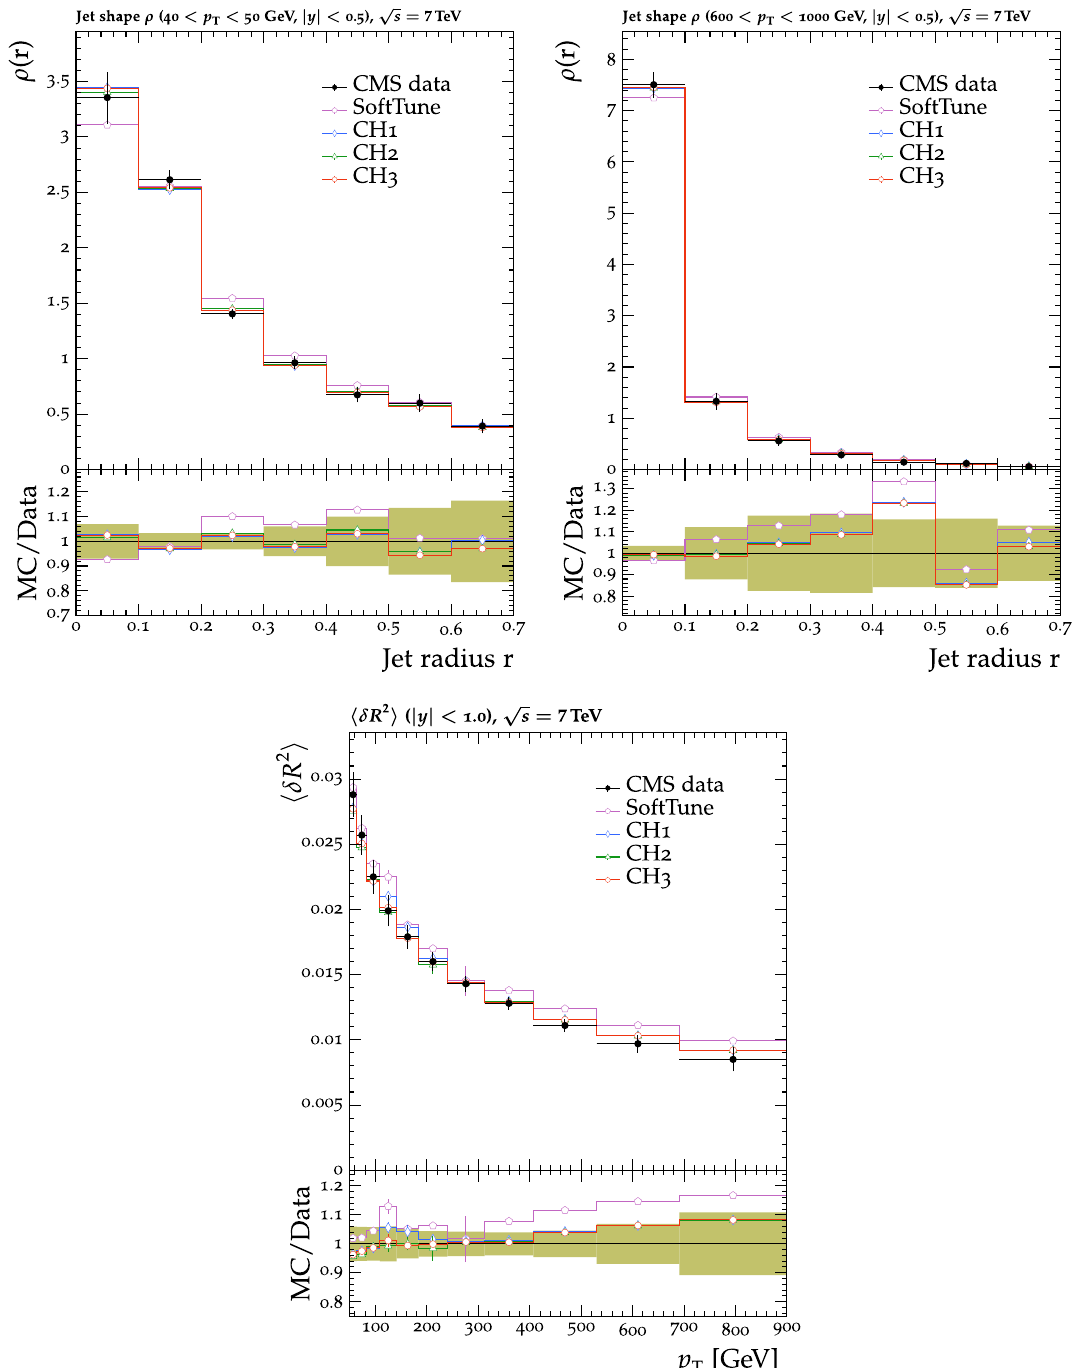
Fig. 15 The differential jet shape ρ( r ) (upper left and right) and the second moment of the jet transverse width (cid:6) δ R 2 (cid:7) in inclusive jet events [43]. CMS inclusive jet data are compared with the predictions from herwig 7, with the SoftTune and CH tunes. The coloured band in the